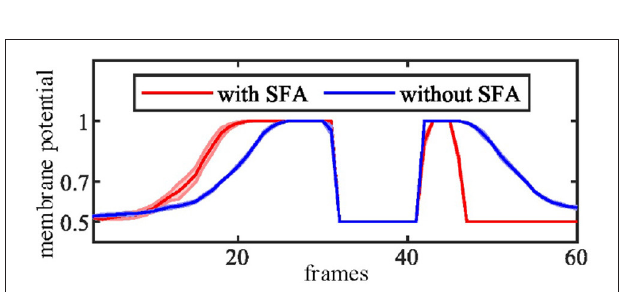
FIGURE 11 | The MLG 1 4 response to looming and receding stimuli with the SFA mechanism. Looming occurred between 10–30 frames, receding 40–50 frames. The trajectories of the object in the stimuli are similar to those in Figure 10A . The results are overlaid from the same experiment repeated ten